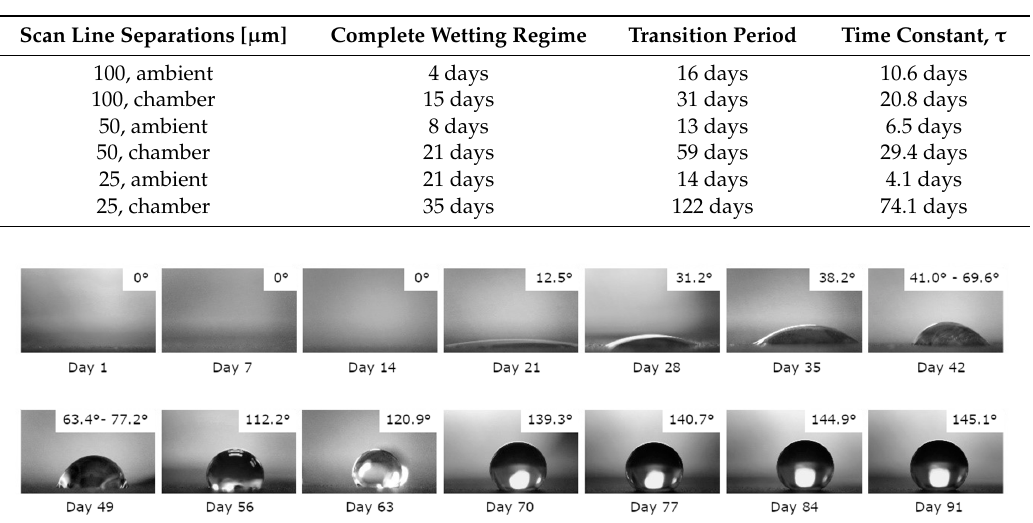
Figure 3. A typical example of droplet evolution from superhydrophilic to superhydrophobic state, through a phase with characteristic irregularly shaped droplets, on uncoated laser-textured surface with ∆ x = ∆ y = 50 µ with ∆ x = ∆ y = 50 μ m.